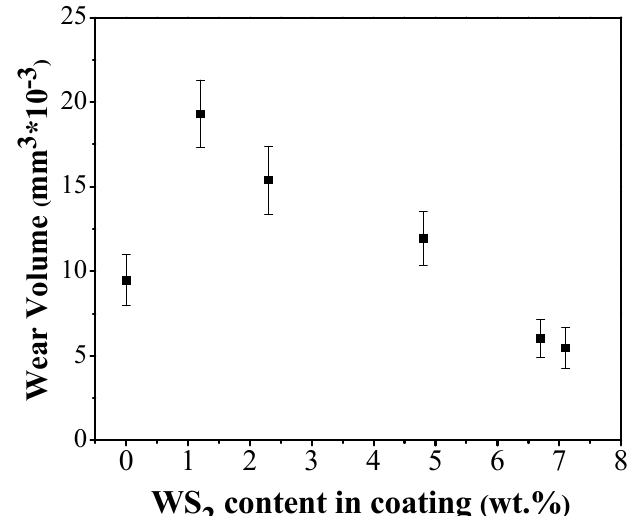
Figure 8. Comparison of wear volumes of Ni–Co coating and Ni–Co/WS 2 coatings with different WS 2 contents.